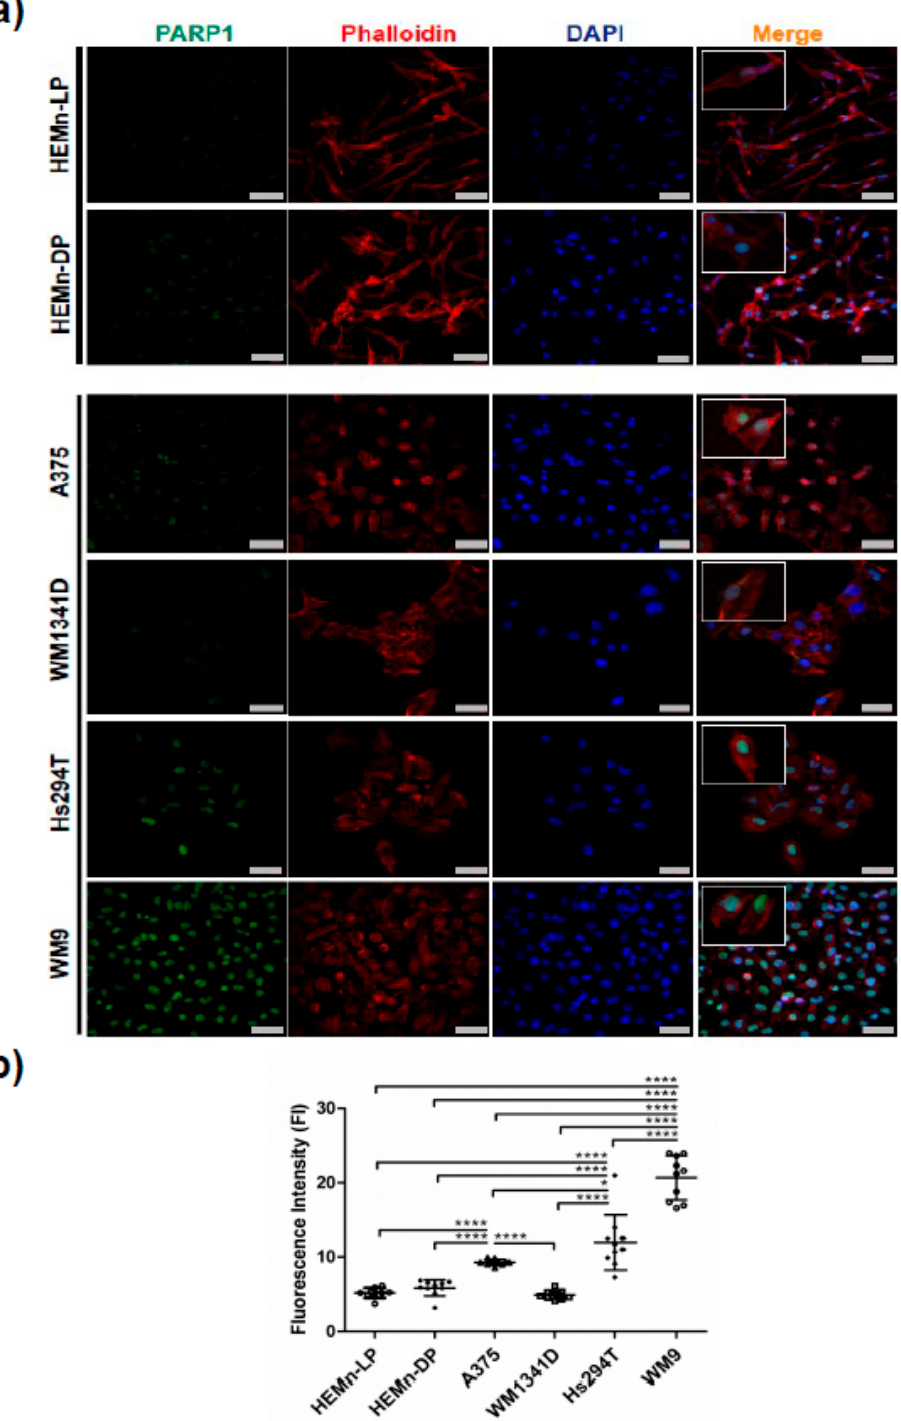
Figure 1. PARP1 localization and fluorescence intensity analysis in normal melanocytes and selected melanoma cell lines. Representative images of normal melanocytes (HEMn-LP and HEMn-DP) and melanoma cell lines derived from the primary tumor (A375 and WM1341D) and lymph node metastases (Hs294T and WM9) stained for PARP1 (green), phalloidin for F-actin (red), and DAPI for cell nuclei (blue) ( a ). Scale bar—20 µ m. The magnification per cell in the merged images was used for better representation of nuclear differences in PARP1 expression per cell between normal melanocytes and melanoma cell lines. Fluorescence intensity of the PARP1 signal presented as a mean (N = 10) ± standard deviation (SD) ( b ). Analysis was performed in Fiji-ImageJ. The significance level was set at p = 0.05–0.01 (*), p ≤ 0.0001